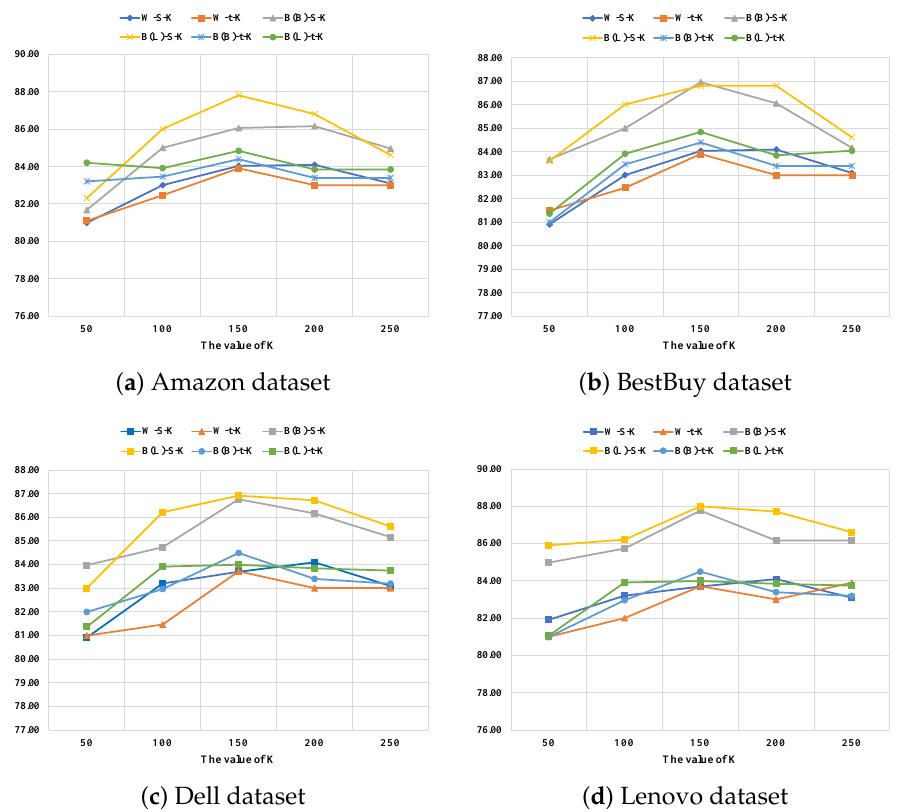
Figure 4. The effect of K value on the experimental results in terms of percentage of the